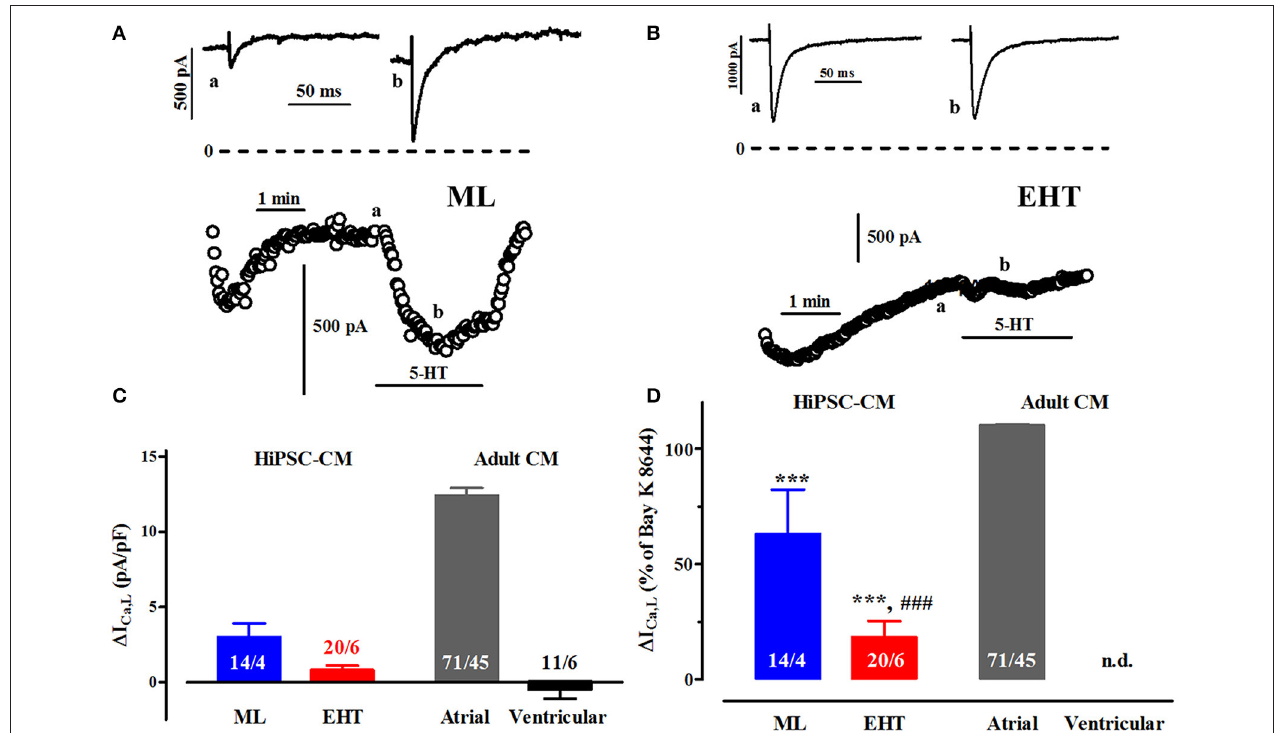
FIGURE 8 | Effects of serotonin on ICa. (A,B) Time course of ICa upon exposure to serotonin (5-HT, 100 µ M) in ML (A) and EHT (B) . Original tracings taken at time points indicated as a and b. (C) Mean values for the increase in ICa,L expressed as delta ( 1 ) current densities in ML, EHT, atrial and ventricular CM. Please note negative values for ventricular cells indicate spontaneous run-down not different from time-matched controls (data not shown). (D) Mean values for the 5-HT-induced increases in ICa,L in ML, EHT, and atrial CM (taken from Figure 8C ) expressed as percentage of response to ( − )-Bay K 8644 (calculated from Figure 5 ). Increase in percent not calculated for ventricular CM. * indicates significance vs. atrial and # vs. ML respectively. N/N indicates number of cells vs. number of isolation for ML and EHT and number of cells/number patients for atrial and ventricular